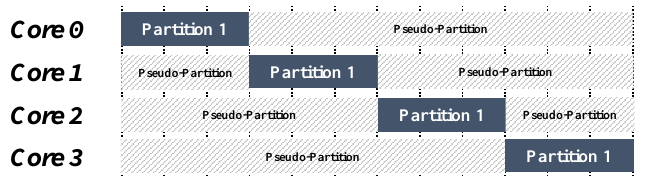
Figure 7. Pseudo-partition for execution flow control.